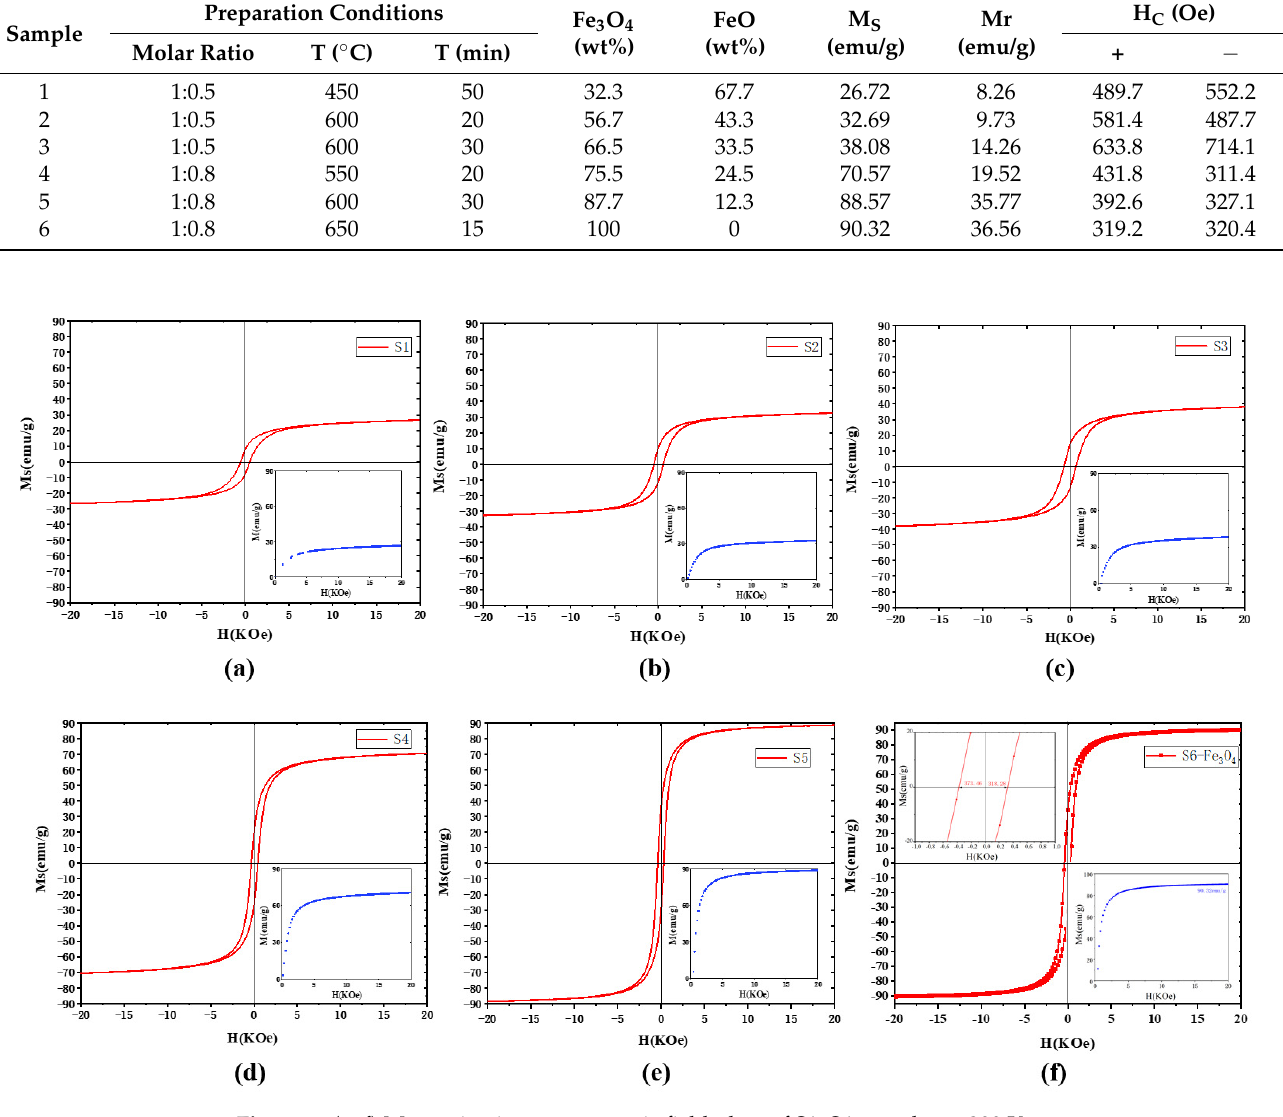
Figure 3. ( a – f ) Magnetization vs. magnetic field plots of S1–S6 samples at 300 K.